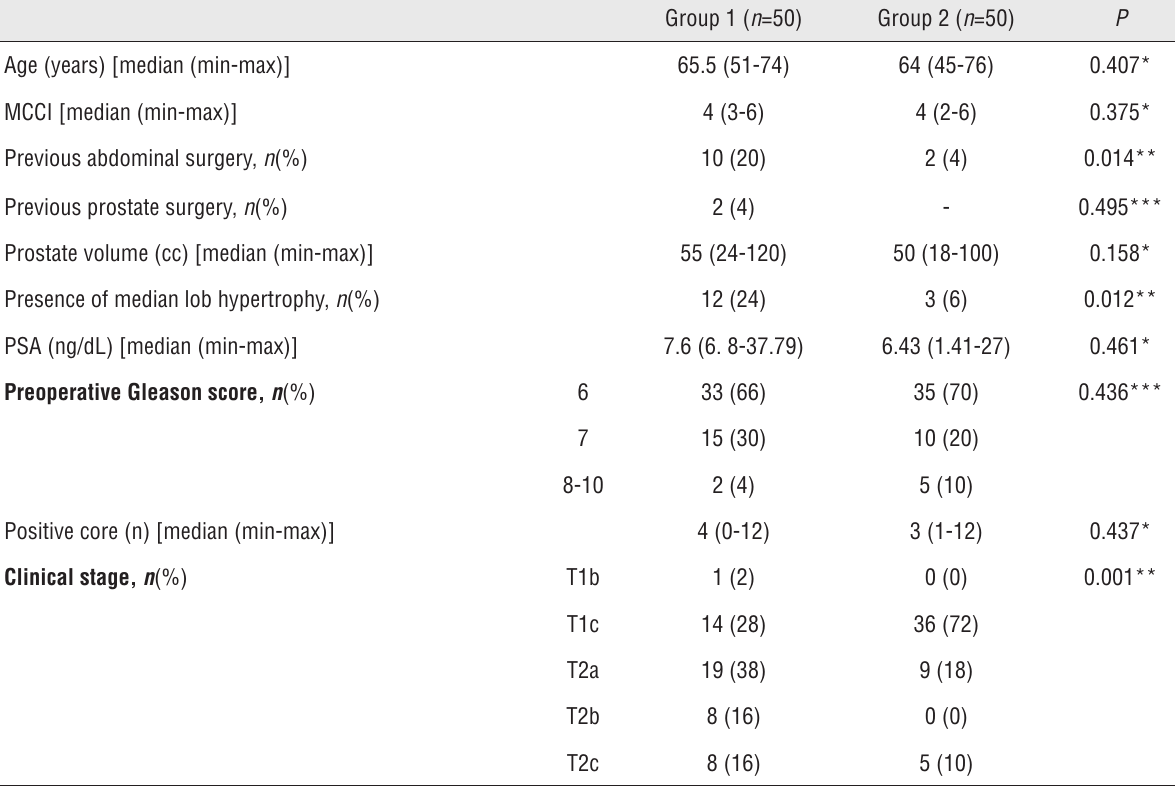
Table 1 - Comparison of preoperative